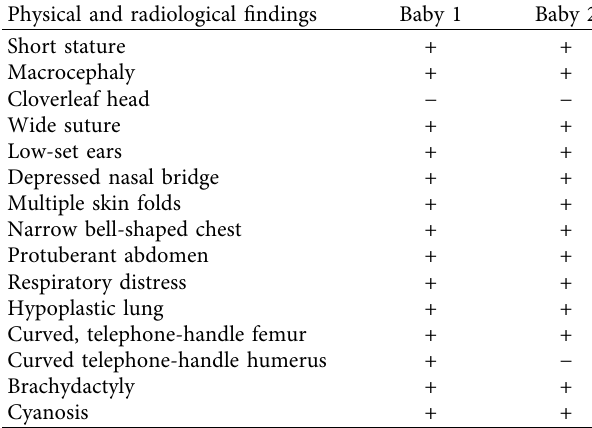
Table 1: Physical examination and radiographical features of babies 1 and 2.